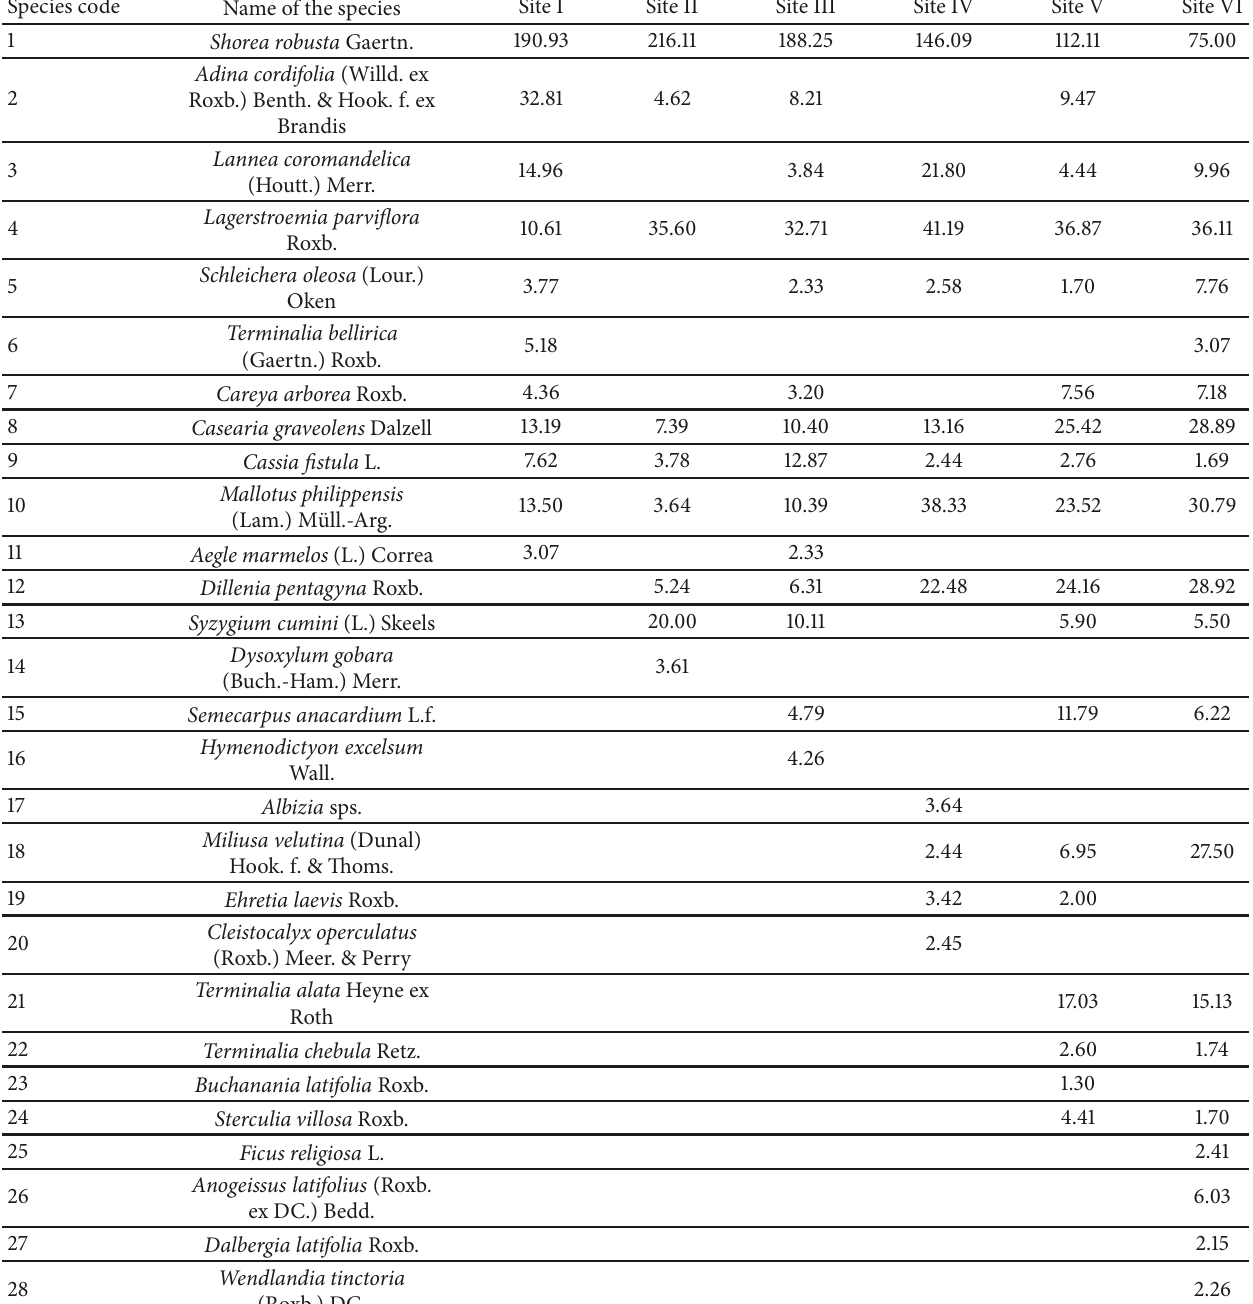
Table 7: IVI of species in Janajagaran